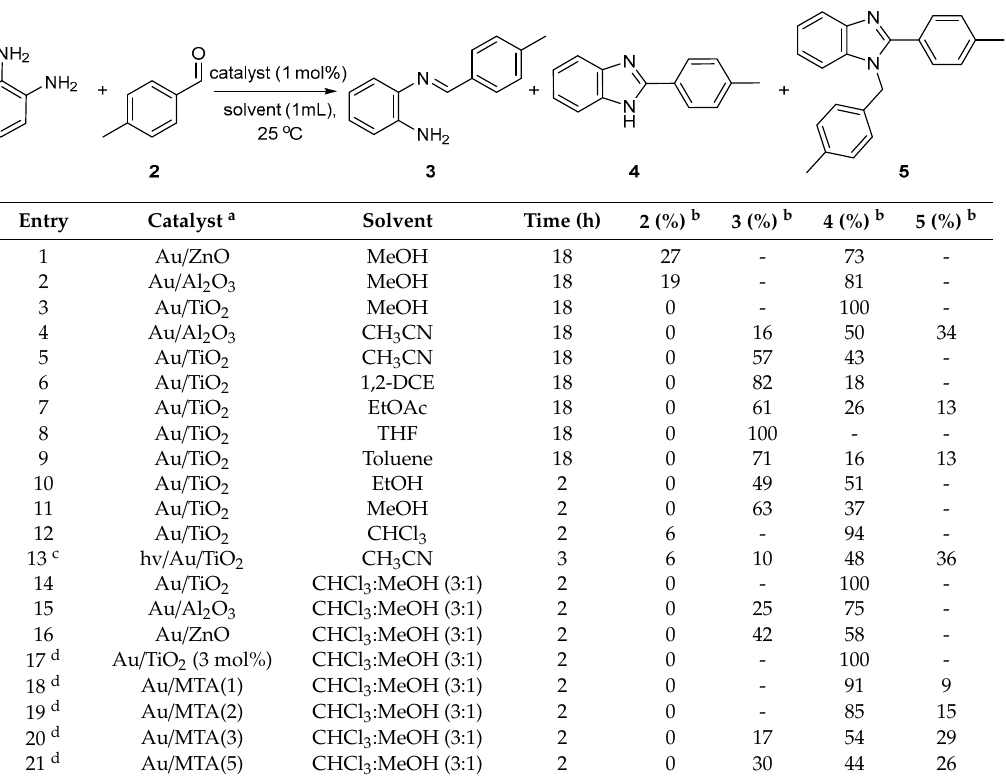
Table 2. Reaction conditions development between 1 and 2 for the synthesis of 4.